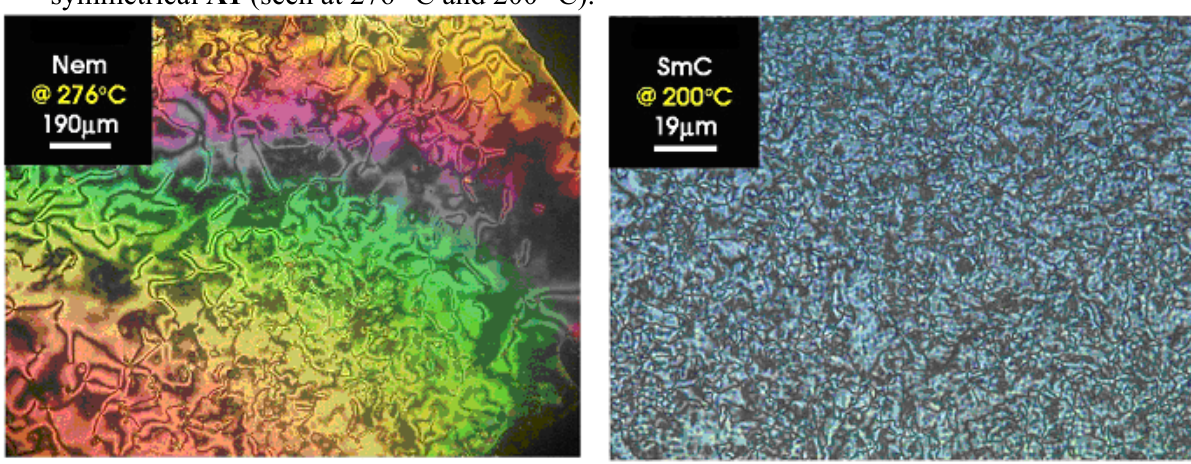
Figure 4. Photomicrographs of the optical textures of mesophases obtained for the symmetrical A1 (seen at 276 ° C and 200 °